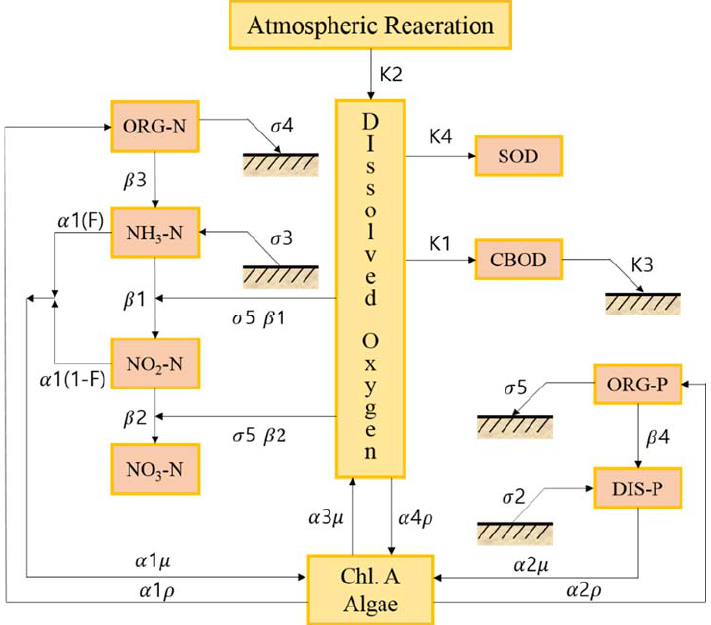
Figure 2. General structure of QUAL2E [35].